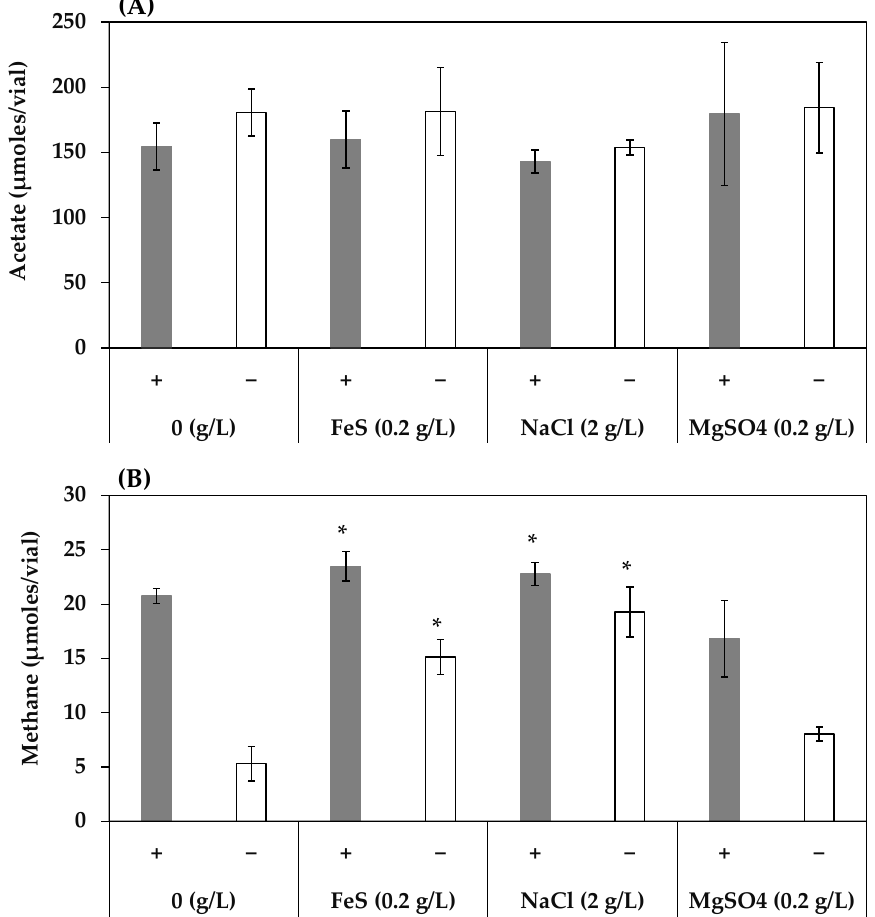
Figure 5. Effect of FeS (0.2 g/L), NaCl (2 g/L), MgSO 4 (0.2 g/L) on the production of acetate ( A ) and methane ( B ) in the HOA consortium in the presence (+) and absence ( − ) of humin. The conditions with 0 g/L (indicating control) are the same as the conditions 4 (with humin) and 2 (without humin) in Figure 1. Vertical bars represent the standard deviation. The acetate and methane production at FeS (0.2 g/L), NaCl (2 g/L), MgSO 4 (0.2 g/L) were compared to those under the condition of 0 g/L of FeS, NaCl, MgSO 4 using the independent t -test. * represents a significant difference at p < 0.05.